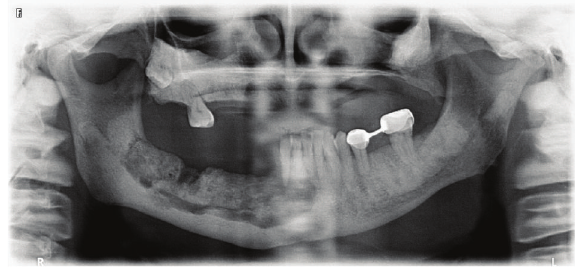
Figure 4: Panoramic radiography view of patient before rehabilita- tion with prostheses in